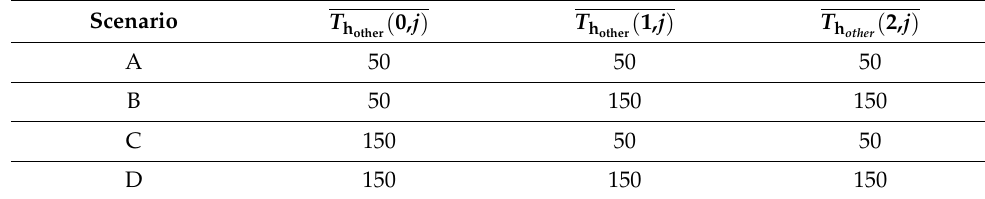
Table 4. Simulation conditions of other user throughputs.